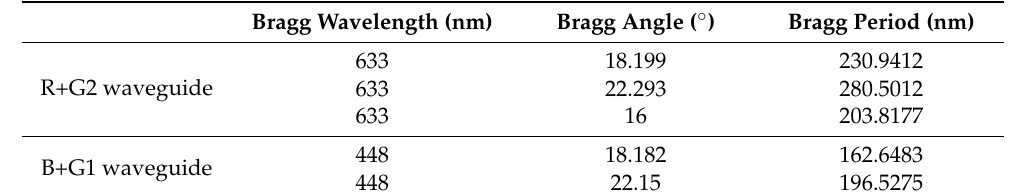
Table 1. Design parameters of PVGs in the R+G2 waveguide and B+G1 waveguide. Figure 5. ( a ) Schematic diagram of the designed waveguide structure. ( b ) The k-vector diagram of the designed dual-layer RGB waveguide structure. ( c ) Plot of the relationship between 𝛬 𝑥 and in- cident angle ranges at the R (633 nm), G (519 nm), and B (448 nm) bands in the designed dual-layer RGB waveguide structure. ( d ) Wavelength-incidence-efficiency plot of Uncompounded PVGs. The red line is the light engine spectrum. ( e ) Wavelength-incidence-efficiency plot of compounded PVGs (corresponding to B+G1 waveguide). ( f ) Wavelength-incidence-efficiency plot of compounded PVGs (corresponding to R+G2 waveguide).